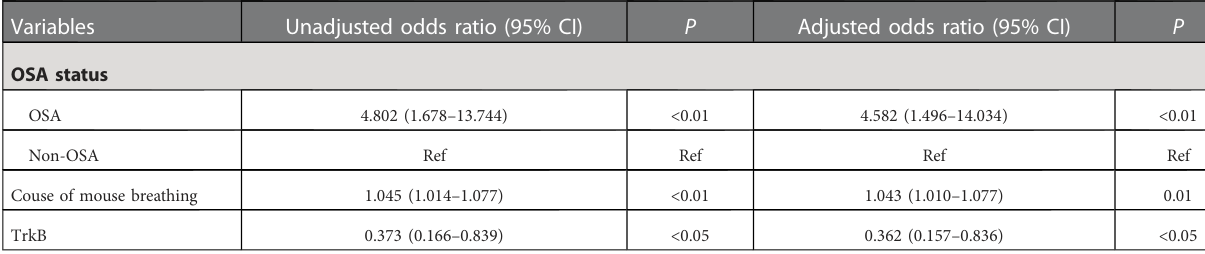
TABLE 6 Results of the logistic regression analysis: assessing the risk of abnormal intelligence in relation to different independent variables.